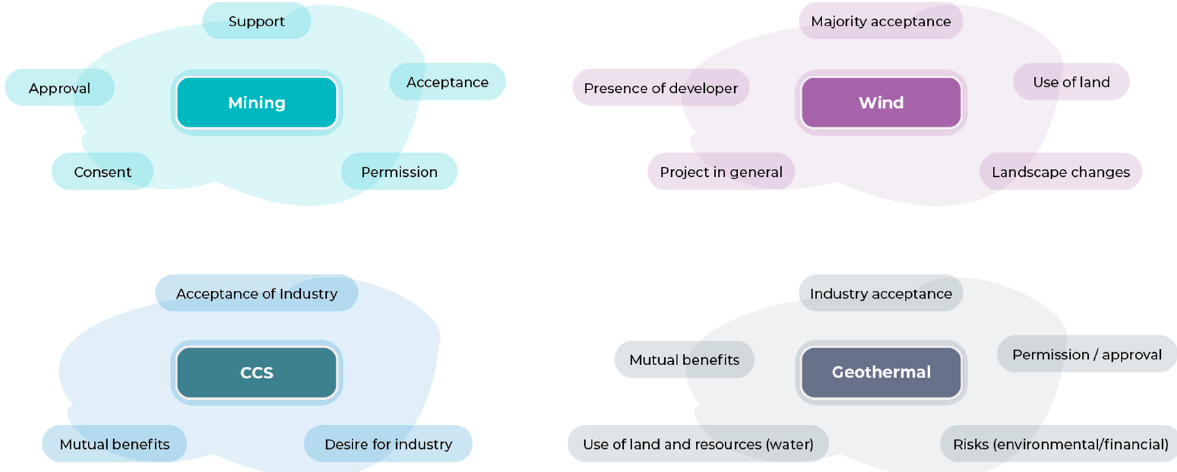
Figure 5. SLO perception around natural resources industries (based on Hall et al.,